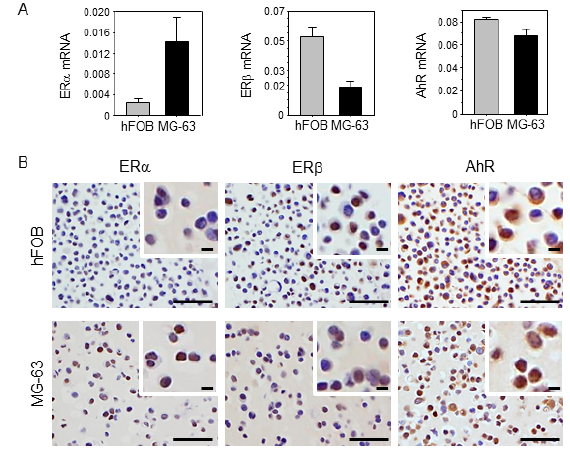
Figure 2. Characteristics of osteoblast (hFOB) and osteosarcoma (MG-63) cell lines. ( A ) Expression levels of ER α , ER β , and AhR in hFOB and MG-63 cells. Data are presented as mean and standard deviation ( n = 3). ( B ) Immunocytochemistry of ER α , ER β , and AhR in hFOB and MG-63 cells. ER α and ER β immunoreactivities in nuclei were predominantly detected in MG-63 and hFOB cells, respectively. AhR immunoreactivity was detected in both cytoplasm and nuclei in hFOB and MG-63 cells. Scale bar, 50 μ m. Upper-right areas are high magnifications of each image. Scale bar, 5 μ m.